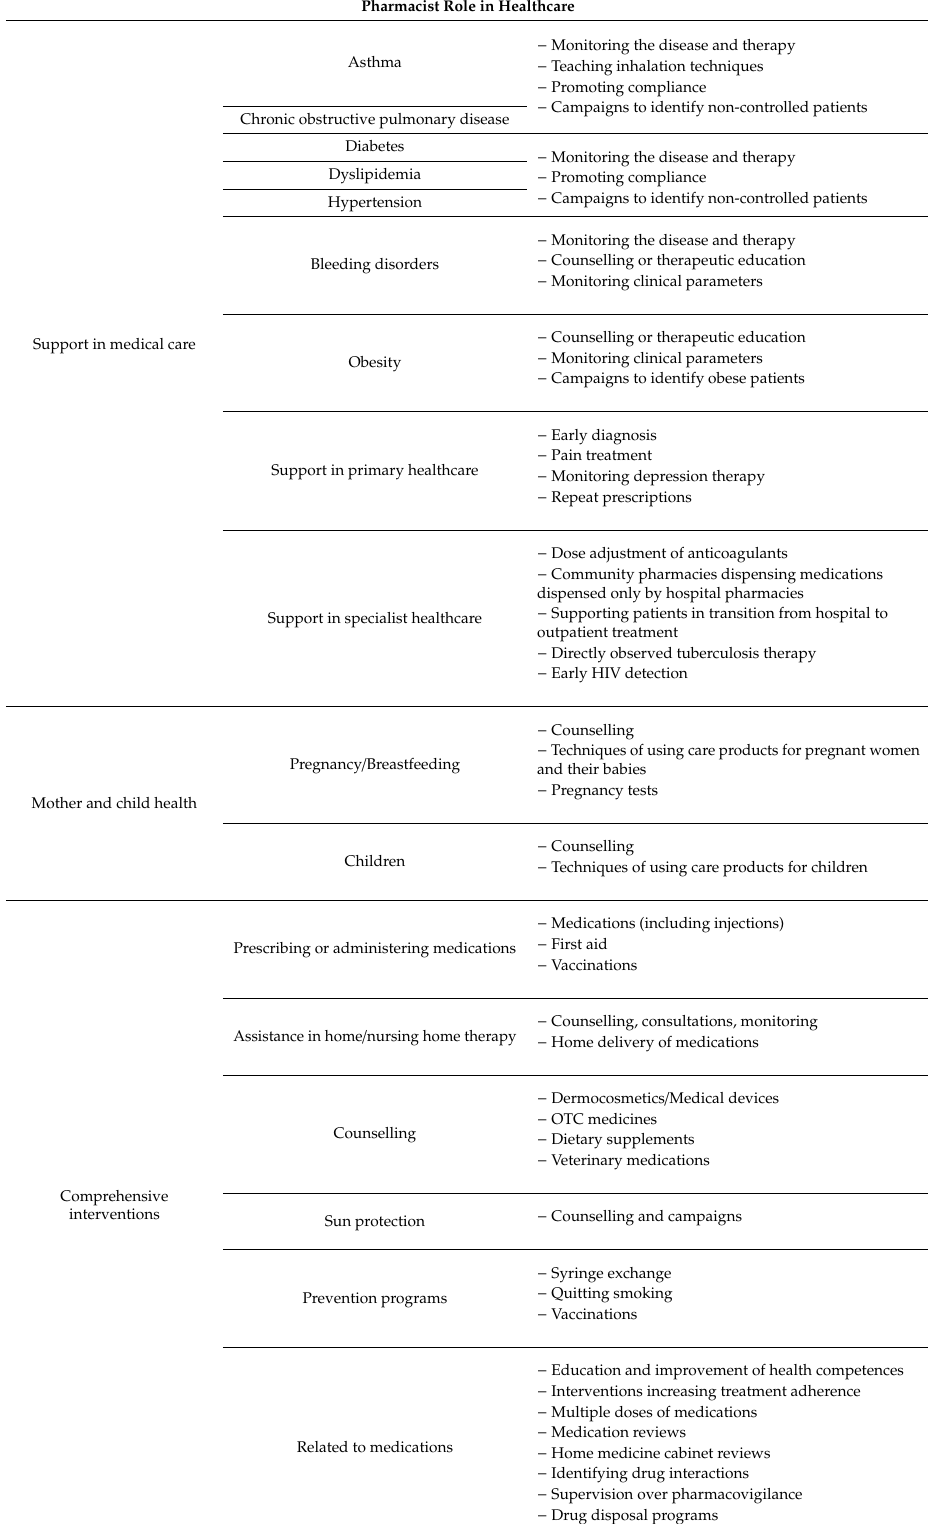
Table 1. The scope of pharmaceutical services and pharmaceutical care supporting primary and specialist